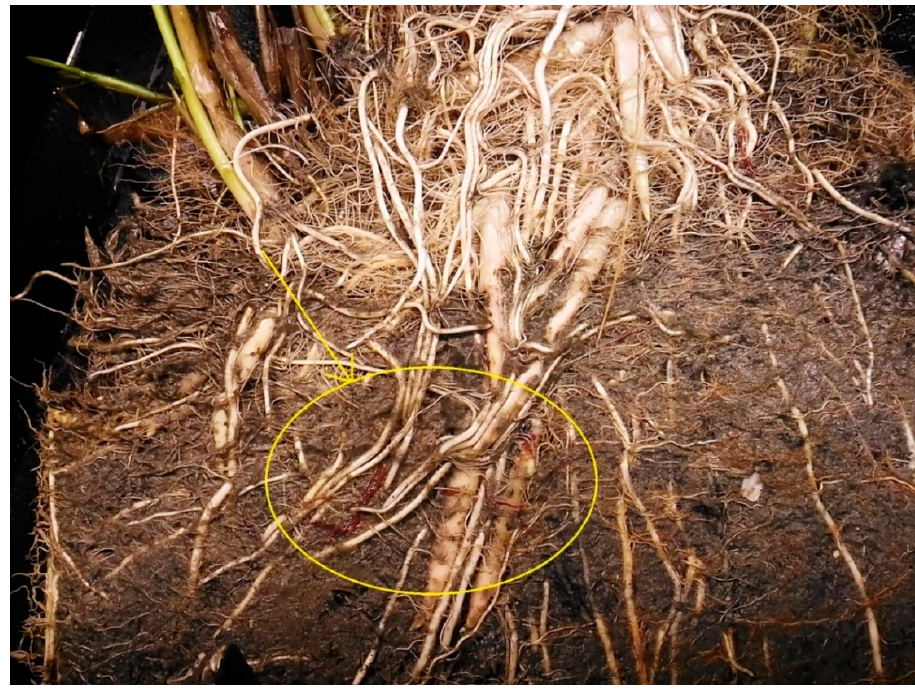
Figure 5. Worms in the anode Plant-MFC 3 (MS100) surviving during 190 day operation.